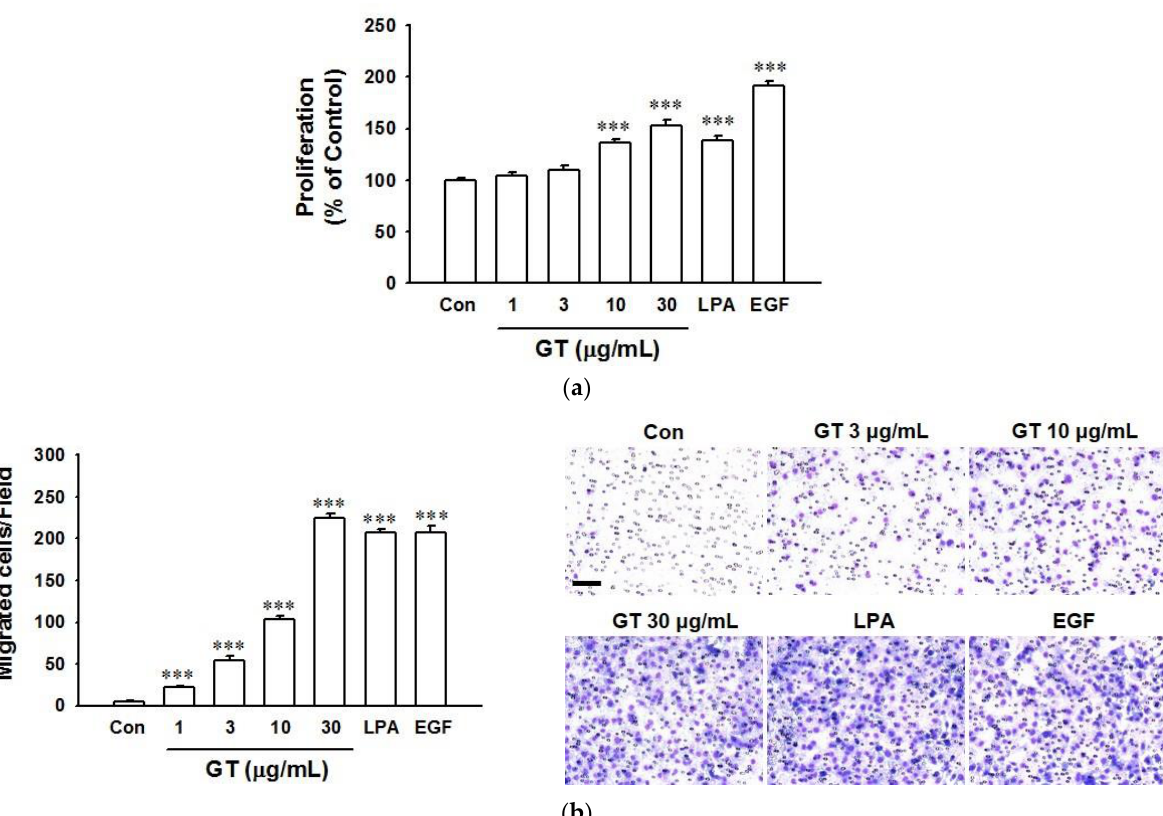
Figure 1. Effects of gintonin on the proliferation and migration of HaCaT cells. ( a ) Cells were incubated in serum-free medium with gintonin (GT; 1–30 µ g/mL), lysophosphatidic acid (LPA, 10 µ M) as a positive control, or epidermal growth factor (EGF, 4 ng/mL) as another positive control for 24 h. The XTT-based assay was then performed. Response in untreated cells (Con) was considered as 100%. Data represent the means ± S.E.M. ( n = 6); ***, p < 0.001 vs. untreated cell (Con). ( b ) Cells were incubated in serum-free medium for 3 h with GT (1–30 µ g/mL), LPA (10 µ M) as a positive control, or EGF (4 ng/mL) as another positive control in the modified Boyden chamber. Migration of cells was then analyzed by counting migrated cells as described in the Materials and Methods section. The right panel shows representative images of migrated cells. Scale bar is equivalent to 100 µ m. Data represent the means ± S.E.M. ( n = 16); *** p < 0.001 vs. untreated cells (Con). GT, gintonin.